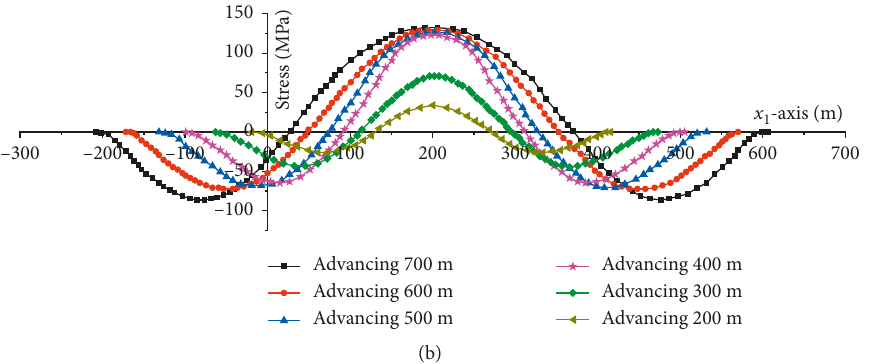
Figure 16: Additional axial stresses along the pipeline presented by simulation: (a) axial stresses distribution on the top of the pipeline and (b) axial stresses distribution at the bottom of the pipeline.